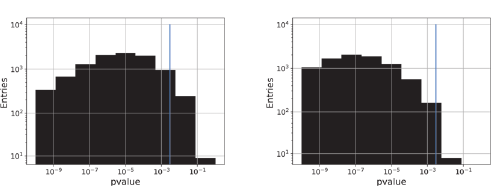
Figure 7: The distributions of p-value. Left figure is for 120 events. Right figure is for 150 event.